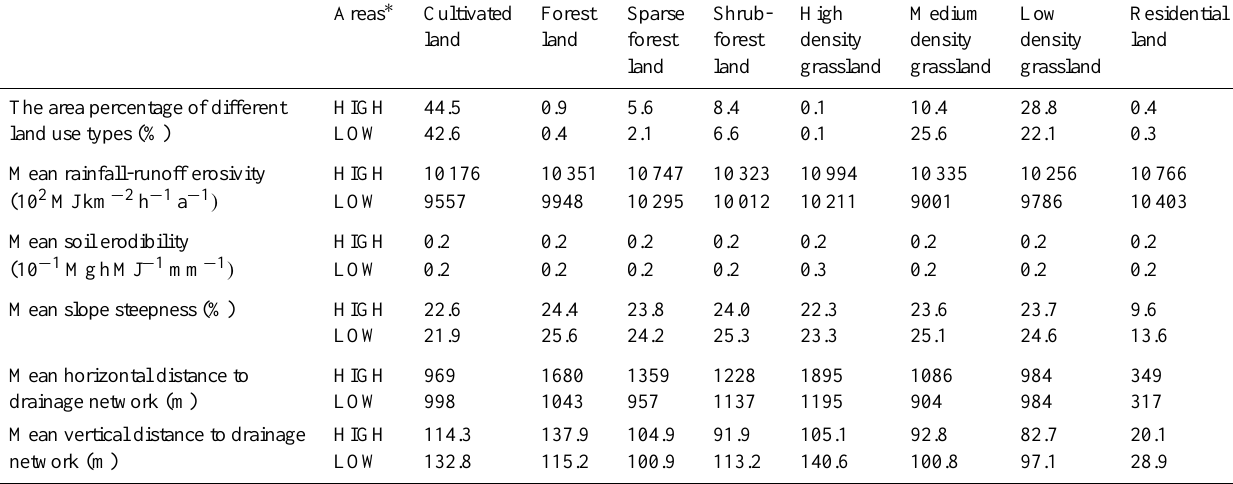
drainage network (m) LOW Mean vertical distance to drainage